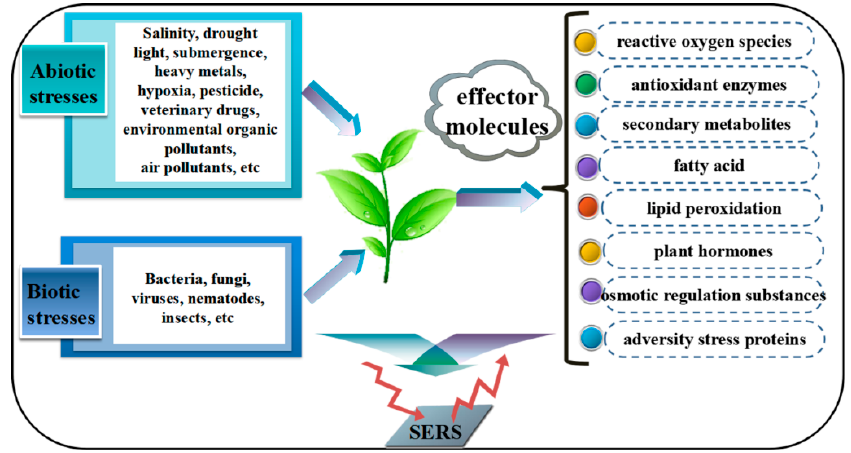
Scheme 1. Abiotic and biotic stresses on the generation of effector molecules in plants.